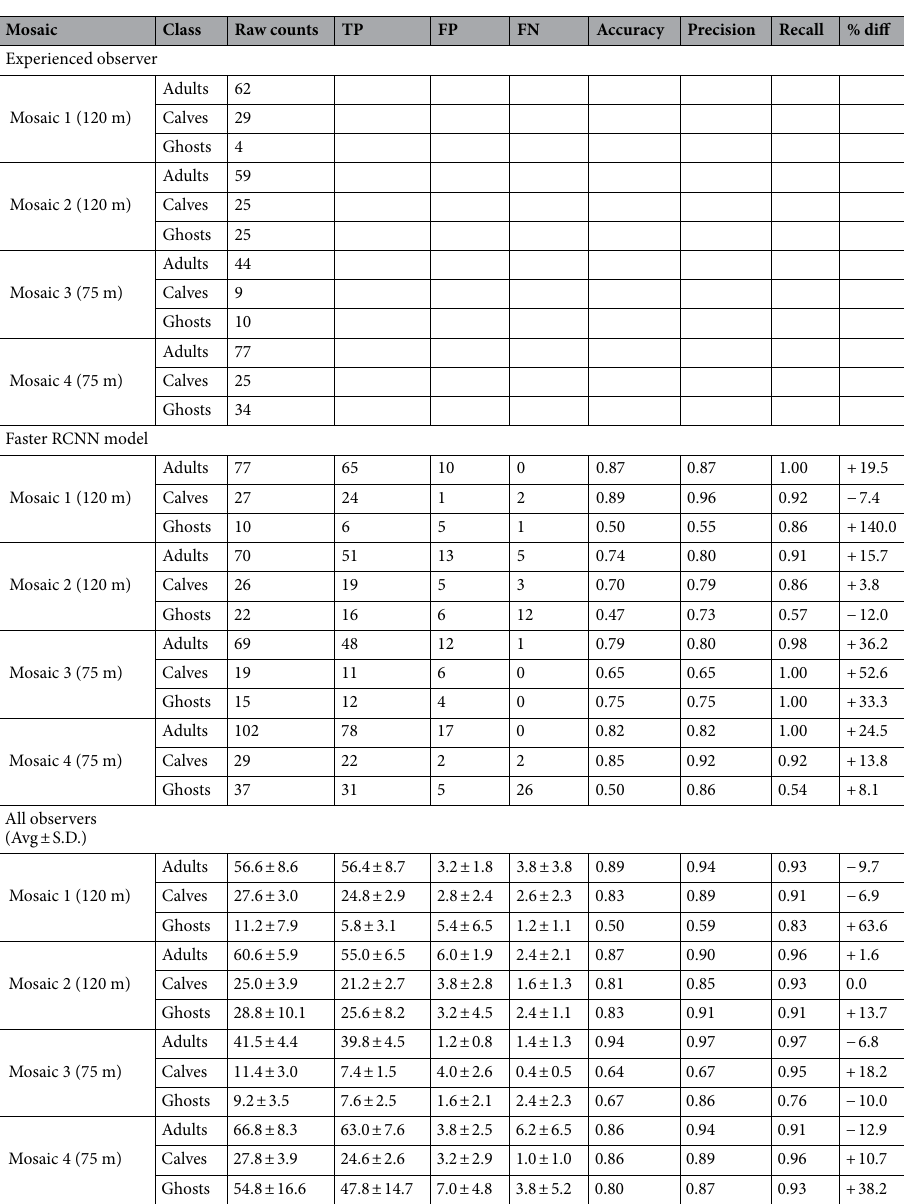
Table 2. Comparison between the Faster-RCNN model, expert observer (AFB), and naïve observers counts (raw counts, true positives: TP, false positives: FP, false negatives: FN, accuracy, precision, recall, and percentage difference: % diff.) of adults, calves, and ghosts caribou for each of the mosaics at 120 m and 75 m AGL in Wapusk National Park, Manitoba,